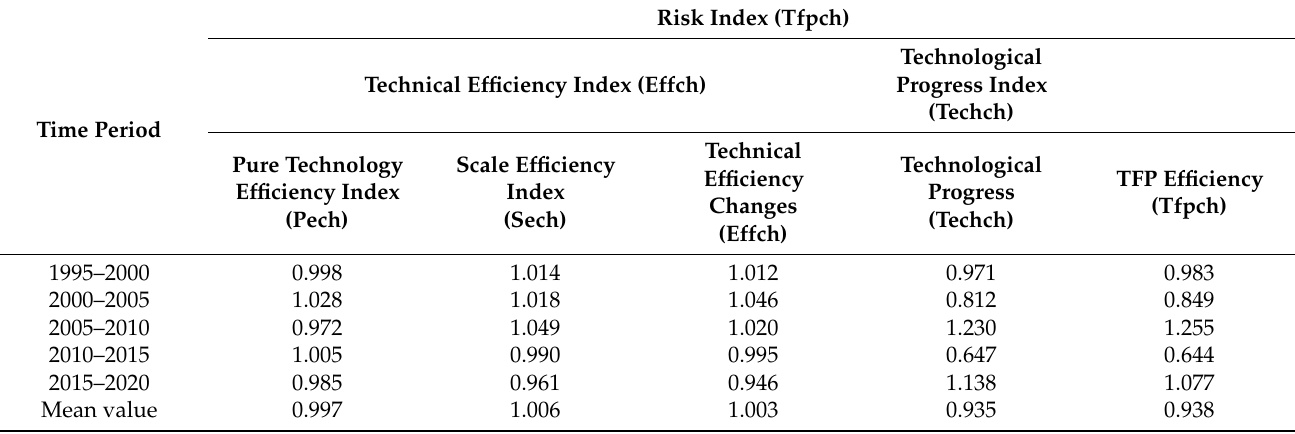
Table 5. Agroecological risk index and decomposition of land in the HRB by time period, 1995–2020.